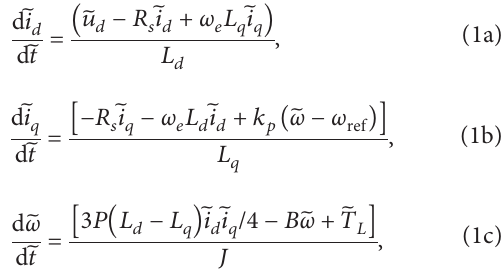
characterized as a combination of light blue-light blue-green colors, and chaotic regions are characterized by yellow and red colors. For b � 0 . 2 and c � 22, the bifurcation diagrams and LLE of SynRM without external inputs as a function of the parameter a are plotted in Figure